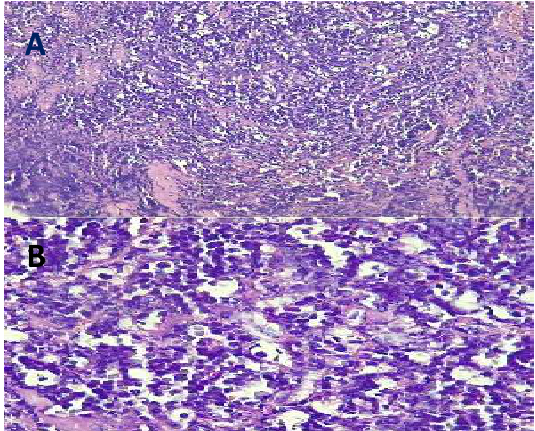
Figure 3: (A-B) Slides revealed lymphocytes with deeply basophilic cytoplasm in a “starry-sky” pattern characteristic of Burkitt